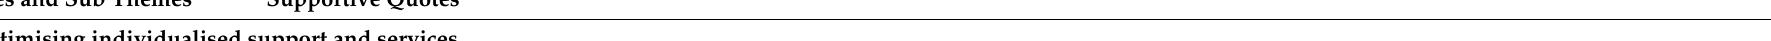
Table 2. Themes, sub-themes and supportive quotes regarding perspectives of adults living with coeliac disease and accessing dietetic services in rural Australia. Themes and Sub